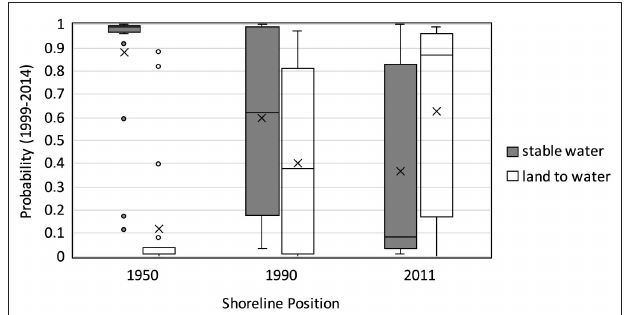
FIGURE 6 | Probabilities for land to water conversion derived from Landsat (1999–2014) at Kay Point (see also Figure 2B ). (A) overlay of probabilities for each pixel, (B) vectorized classifications for > 0.5 (white), > 0.45 (blue), and > 0.55 (red). Background: Band 2 (blue) of Sentinel-2 Sep 20 2018.